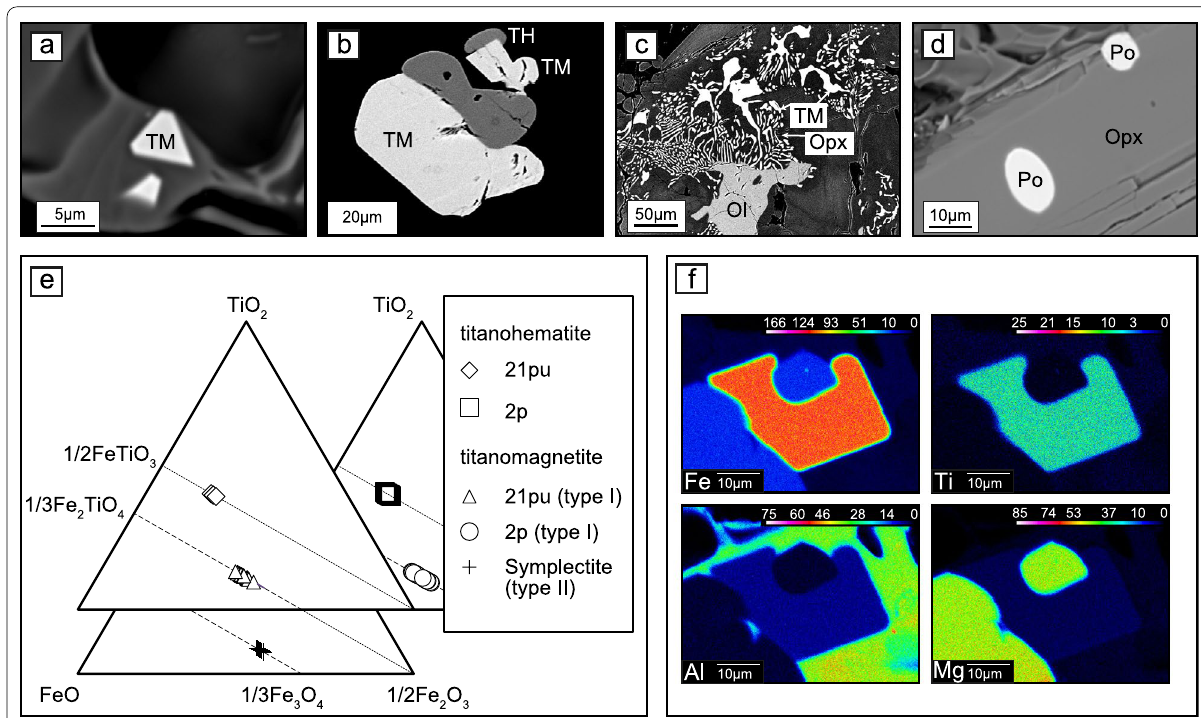
Fig. 3 Representative back-scattered electron images ( a – d ) and electron probe analyses ( e , f ) of opaque minerals in the pumice fall deposits. a Euhedral homogeneous TM (type I) in volcanic glass. b Bleb-shaped TH associated with TM (type I). c TM–Opx symplectite (type II). d Globular pyrrhotite is included in orthopyroxene. TM titanomagnetite, TH titanohematite, Opx orthopyroxene, Ol olivine, Po pyrrhotite. e FeO-1/2Fe 2 O 3 –TiO 2 ternary diagrams showing chemical compositions of Fe–Ti oxides. The dashed and dotted lines indicate solid solutions of TM and TH, respectively. f Representative elemental maps of TM (type I) for Fe, Ti, Al, and Mg. The color bar beside each map indicates the relative intensity